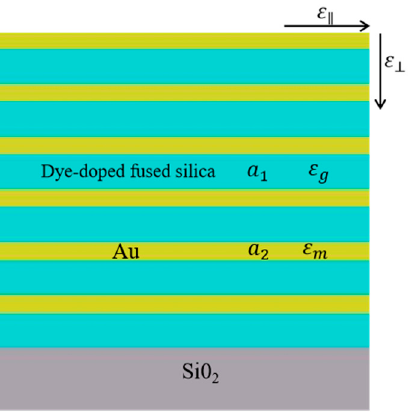
Figure 1. Cross − section of the Au/dye − doped fused silica multilayered metamaterial.